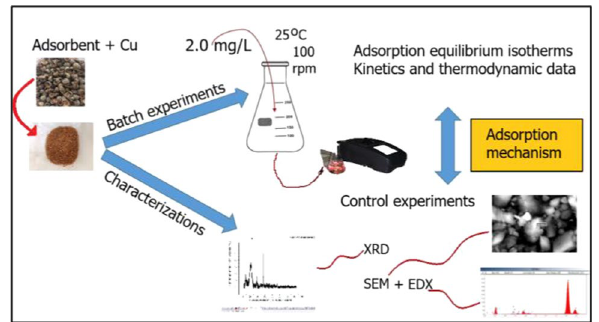
Fig. 1 Schematic representation of the experimental